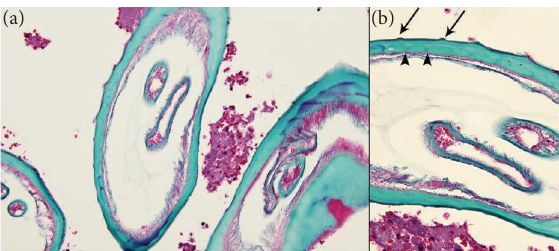
Figure 3: Trichrome-stained sections of O. lupi revealing relevant morphological features ((a) 200x magnifcation and (b) 400x mag- nifcation). Arrows indicate external cuticular ridges, and arrowheads indicate internal striae. Table 1: Summary of reported cases of human Onchocerca lupi infection in the United